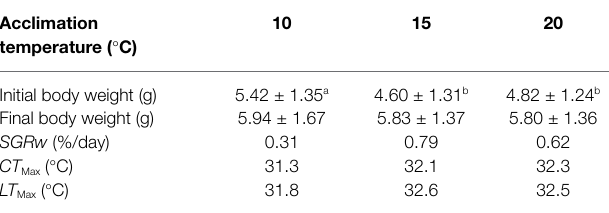
TABLE 1 | Final size, specific growth rate of body weight ( SGR W ), upper thermal tolerance ( CT Max ), and lethal thermal maximum ( LT Max ) of Oxygymnocypris stewarti juveniles in three acclimation temperature